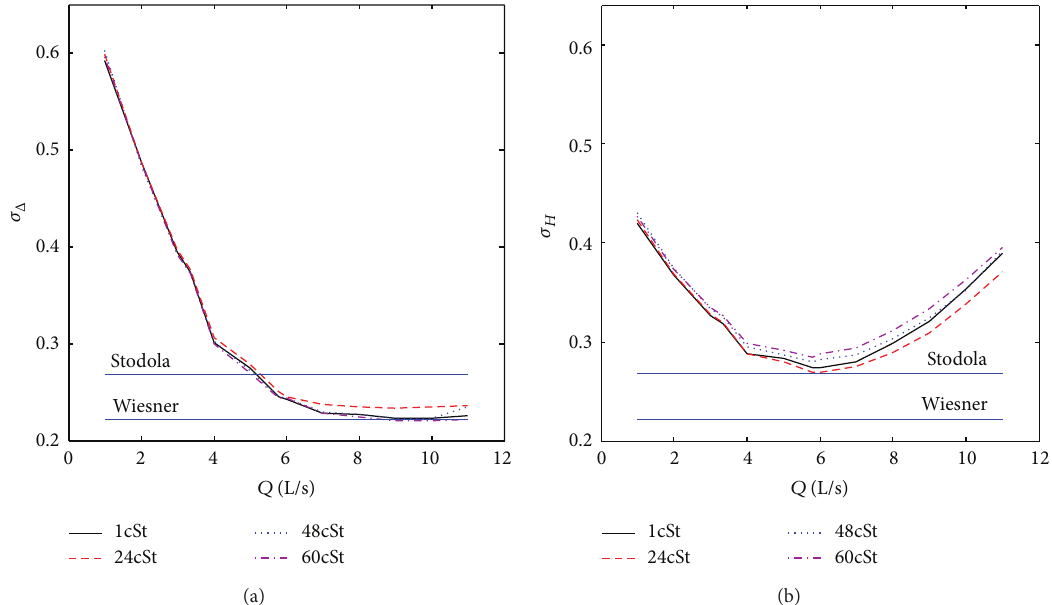
Figure 6: Slip factors against flow rate at four viscosities and Ra = 50 𝜇 m roughness, (a) based on velocity triangle at impeller outlet, (b) from impeller theoretical head of 3D viscous flow.